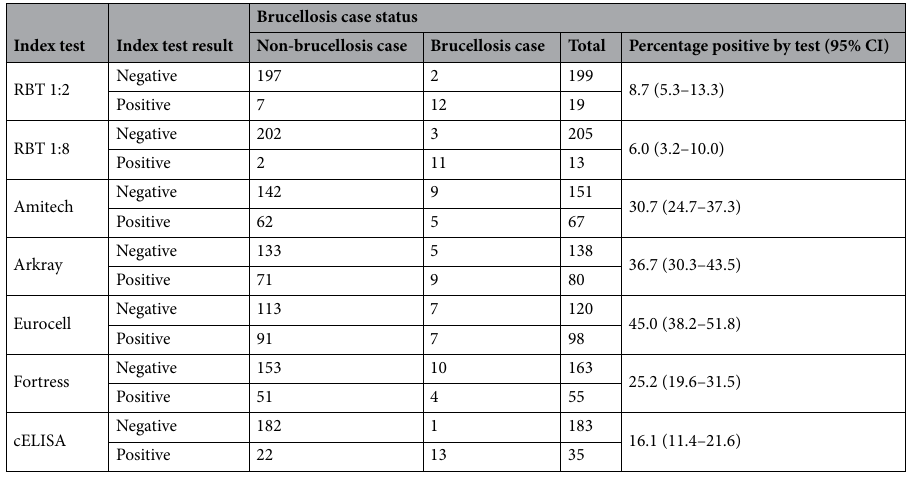
Table 1. Cross tabulation of the index test results by patient brucellosis case status (n = 218, of which 14 were brucellosis cases and 204 were non-brucellosis cases). RBT the Rose Bengal test, cELISA competitive enzyme- linked immunosorbent assay, CI confidence interval.